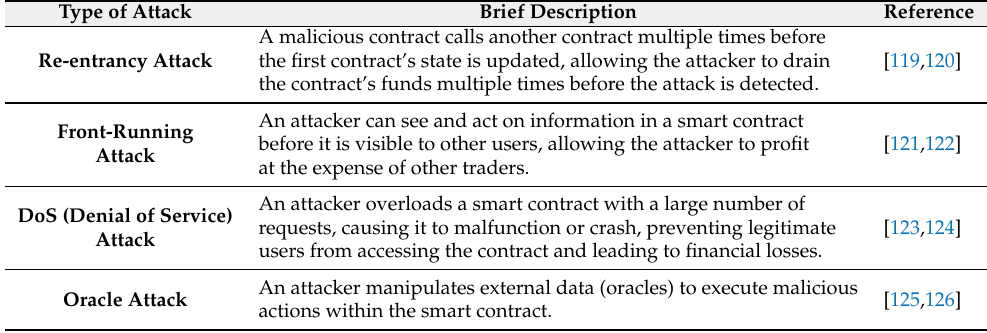
Table 3. Summary of different cyberattacks targeting smart contract